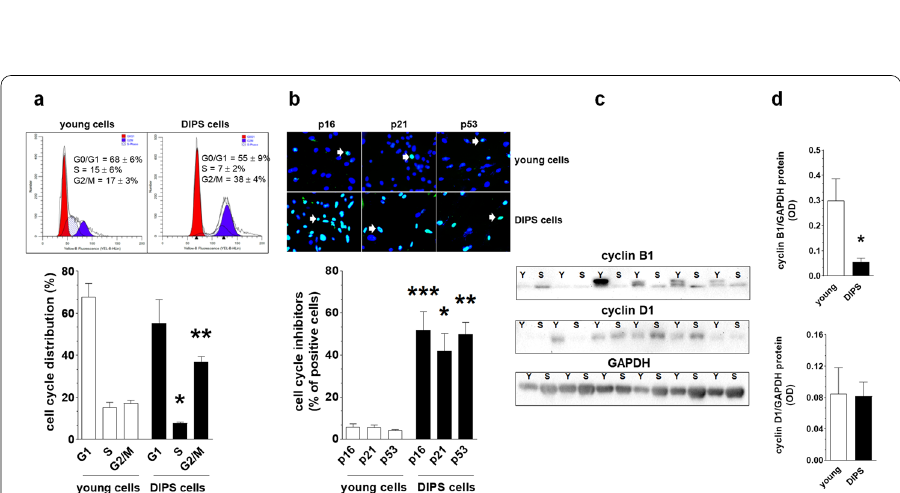
Fig. 2 Characteristics of DIPS‑associated growth arrest according to cell distribution in the cell cycle and the analysis of cell cycle inhibitory proteins and cell cycle‑promoting cyclins. Analysis of cell distribution in particular phases of mitotic cycle using flow cytometry with cells stained with propidium iodide. The cells gathered in the G1 phase are marked in red, whereas cells belonging to the G2/M stage are marked in blue. The quantification (%) of cells arrested in G0/G1, S, and G2/M phases is shown on the representative histograms ( a ). Determination of senescence‑specific cell cycle inhibitors (p16, p21, and p53) in young and DIPS cells. White arrows indicate exemplary positive cells. Magnification 200, objective aperture × 0.35 ( b ). Changes in cyclin B1 and D1 level during DIPS ( c ) quantified with densitometry ( d ). Because the cytostatic effect of drugs is diverse for individual samples, the blots represent results obtained for all tested cultures (Y—young cells; S—senescent/DIPS cells). Results derive from 6–8 independent experiments with HGSOCs obtained from different donors. Flow cytometry was performed using 10 000 cells, whereas the quantification of cell cycle inhibitors was based on the analysis of 500 randomly selected cells per group. The results are expressed as the means SEM. * p < 0.05; ** p < 0.01; *** p < 0.001 vs. young ±